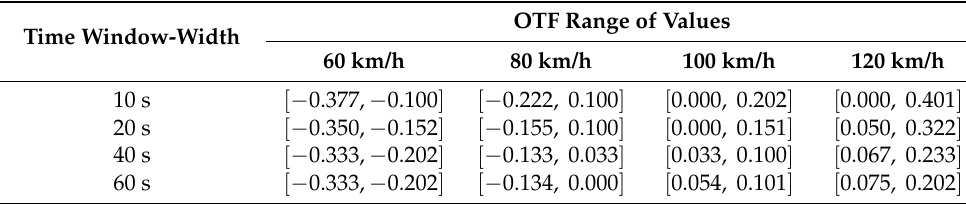
Table 2. The range of OTF under 4 speed conditions with different time window-width. Time